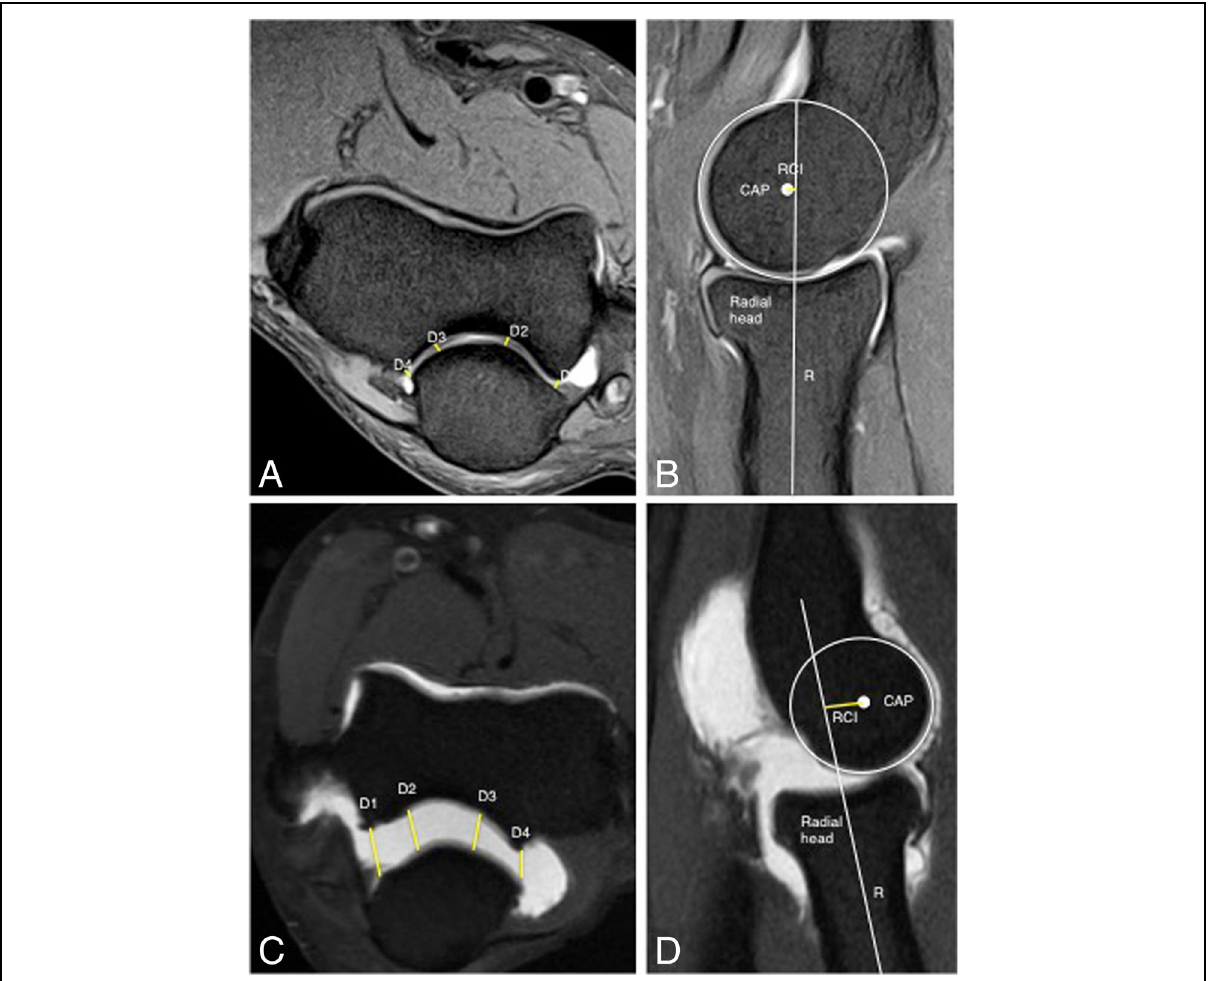
Fig. 29 Axial FS PD-weighted MRI ( a ) showing the measurement of normal ulnohumeral incongruity: the distance between the trochlear joint surface and olecranon joint surface (D1, D2, D3, and D4). Sagittal FS PD-weighted MRI ( b ) showing the measurement of normal radiocapitellar incongruity (RCI): the distance between CAP and R. Axial FS PD-weighted MRI showing an ulnohumeral incongruity of more 1 mm ( c ). Sagittal FS PD-weight MRI showing a radiocapitellar incongruity of more 2 mm ( d